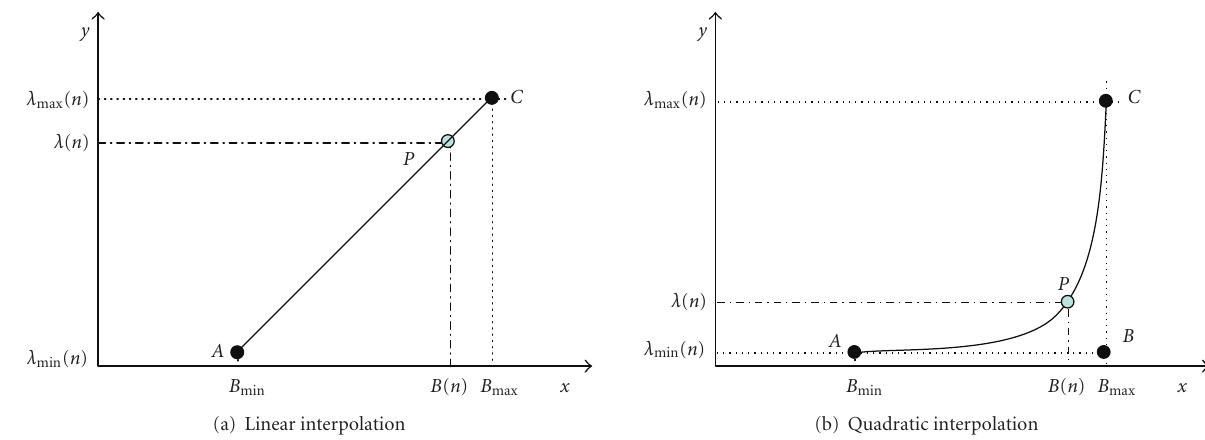
Figure 3: Interpolation of λ ( n ) between λ min ( n ) and λ max ( n ) as a function of the current bu ff